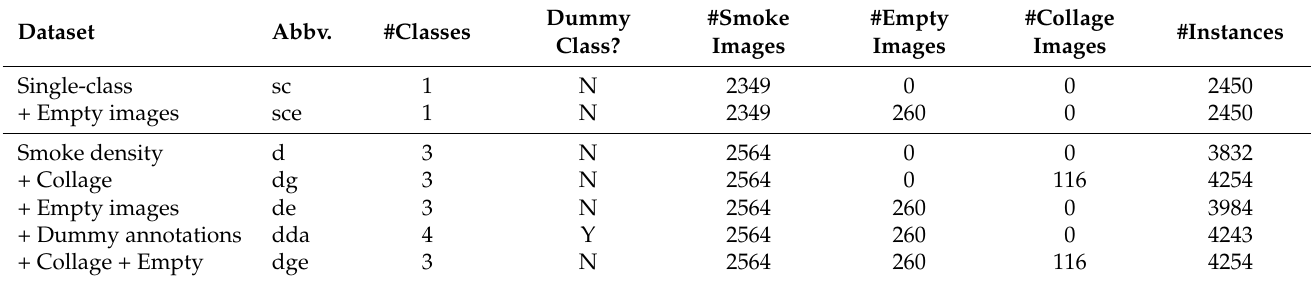
Table 2. Dataset configurations’